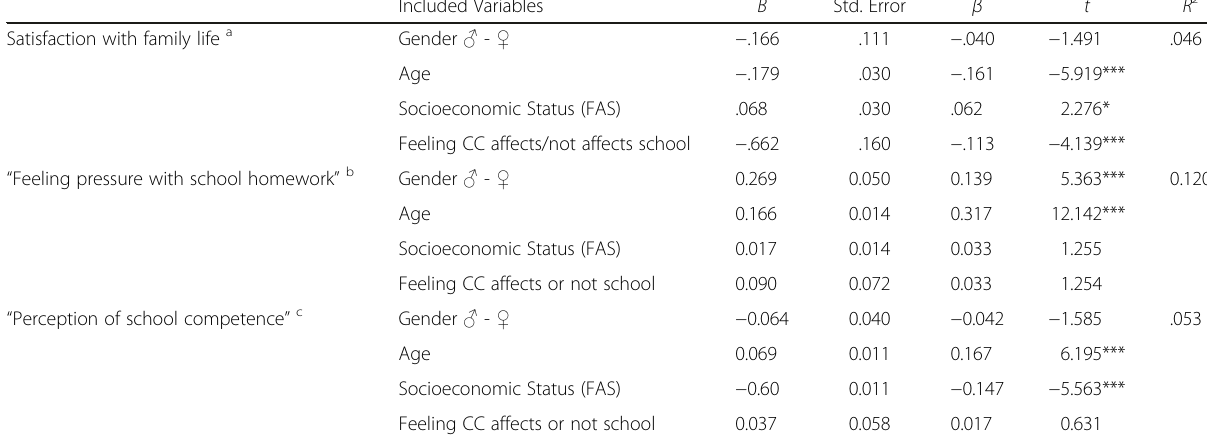
Table 5 Predicting 1) adolescents ’ satisfaction with family life and 2) “ feeling pressure with school homework ” and “ perception of school competence, using as predictors gender, age, FAS and feeling that CC affects or not school participation (multiple linear regression model)